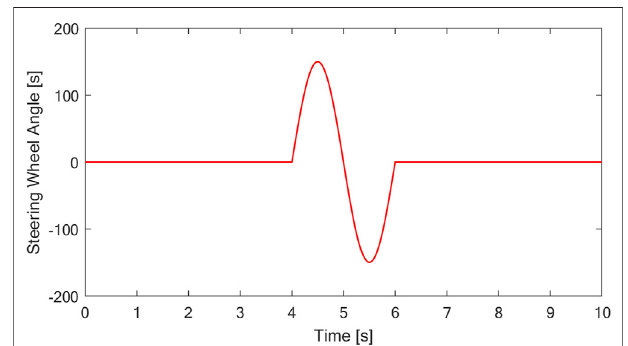
Frontiers in Bioengineering and Biotechnology |